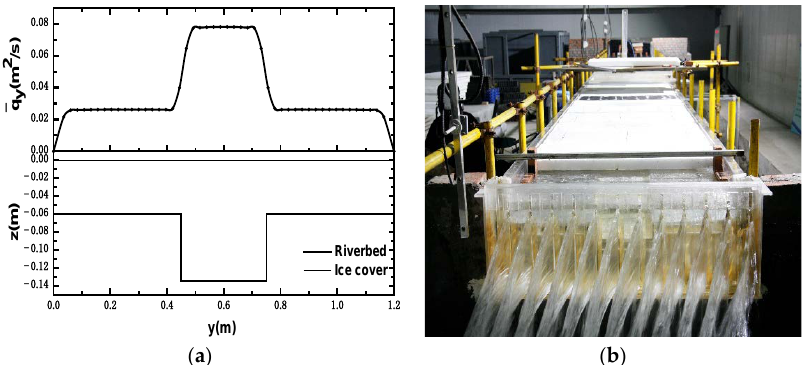
Figure 10. Experimental flume section with main channel and floodplain: ( a ) section topography showing ice cover, riverbed distribution, and cross-sectional relative-unit discharge; ( b ) photo of experimental flume.